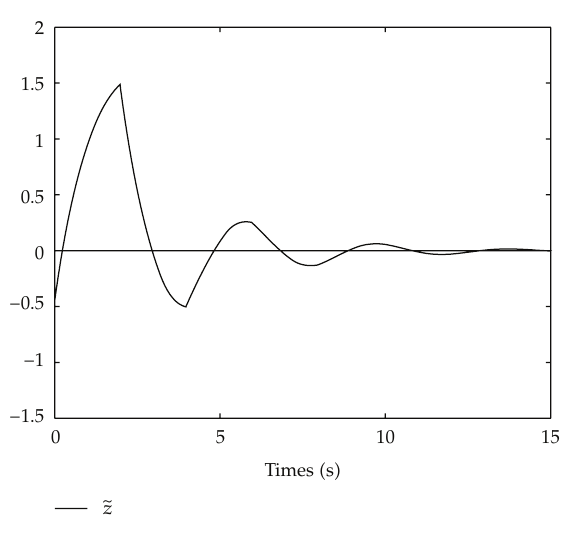
Figure 3: Error estimation signal (cid:14) z (cid:2) t (cid:3) with the designed filter.